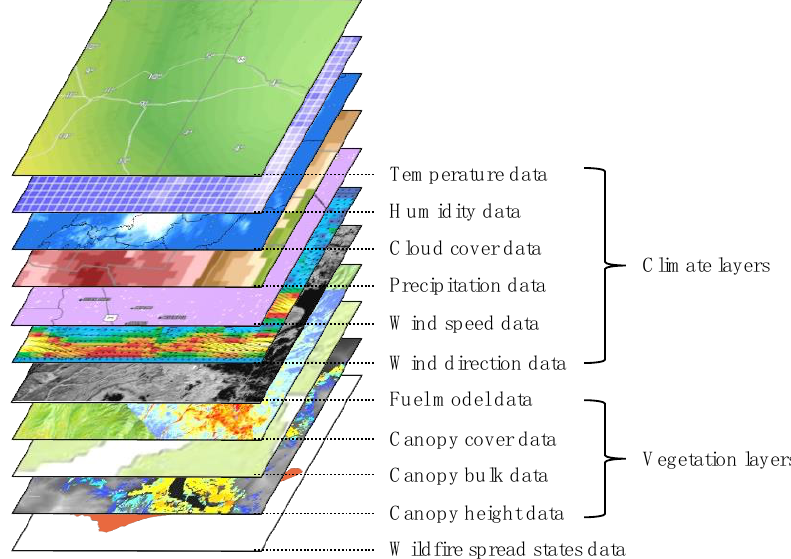
Figure 9. Structure of wildfire dataset for the